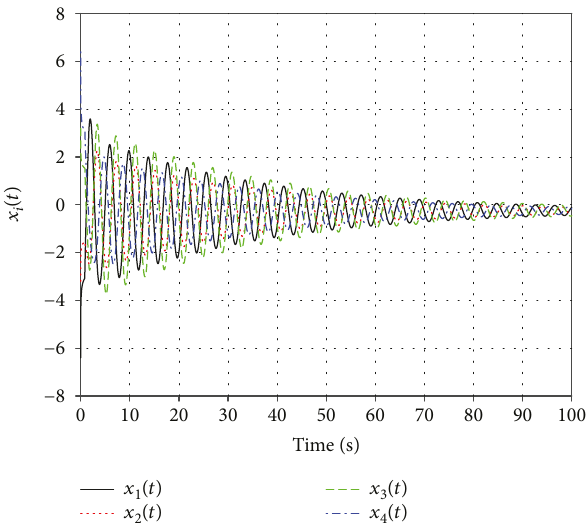
t applying the protocol in (7) i 2